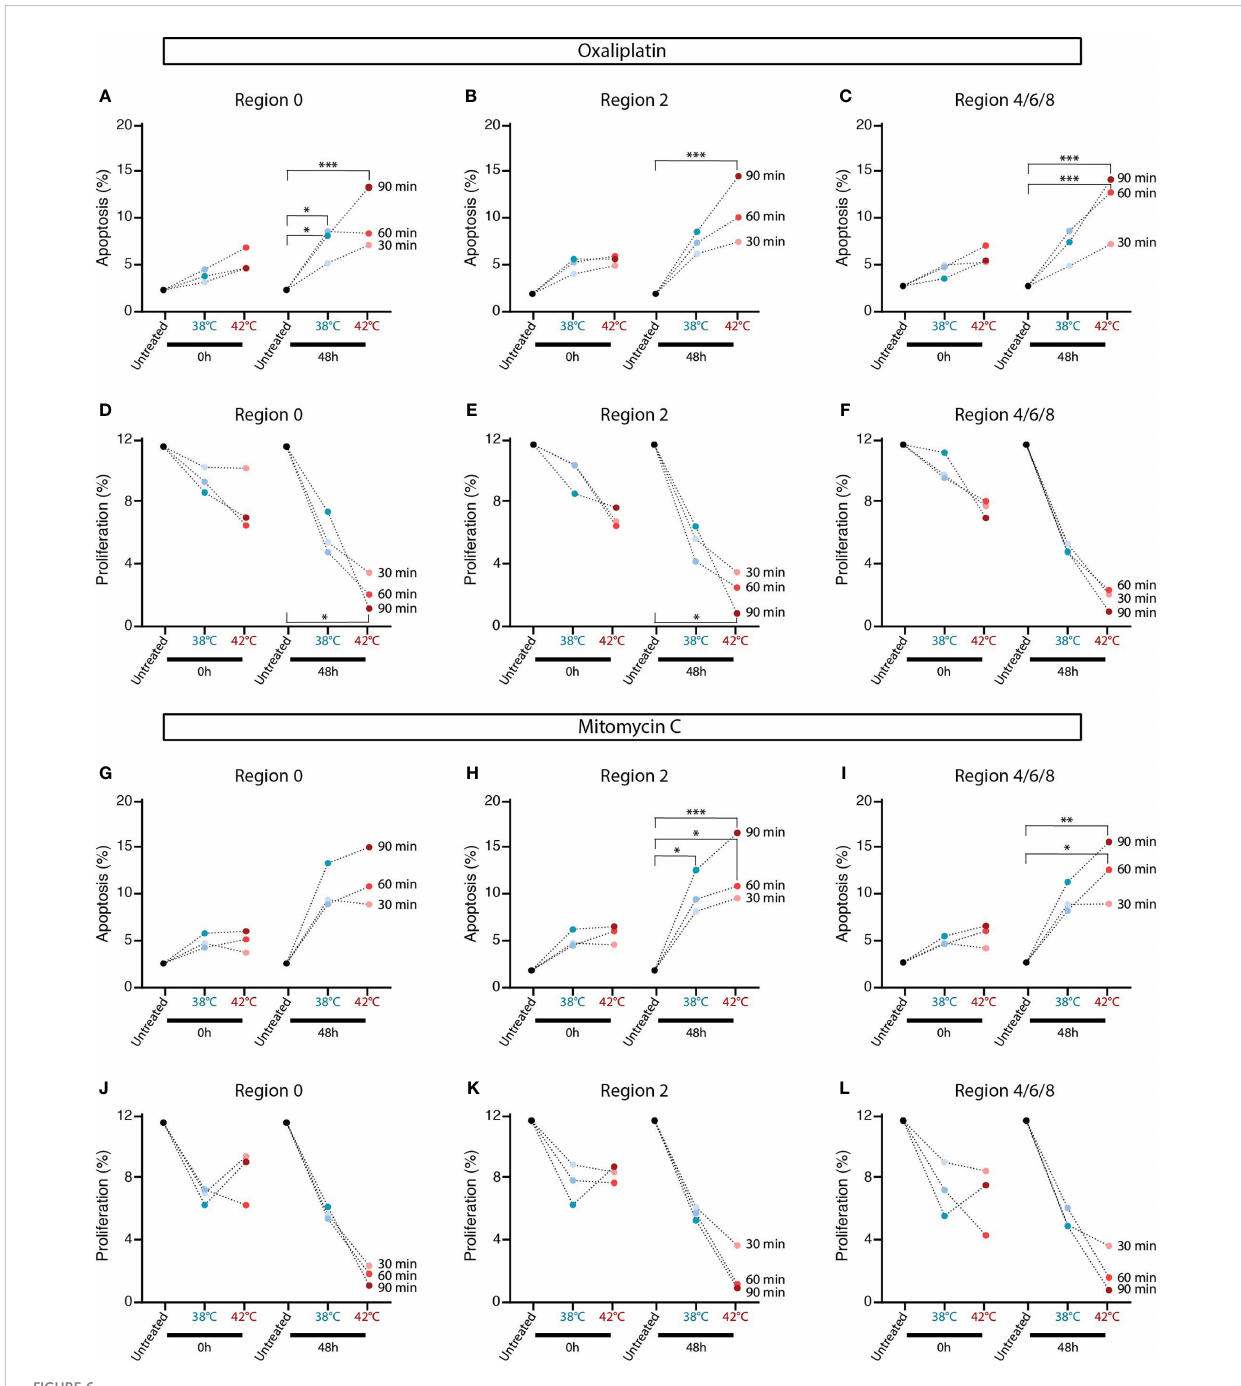
FIGURE 6 In oxaliplatin and mitomycin-C (MMC) HIPEC treated rats increased tumor cell apoptosis and reduced proliferation was observed. Percentages apoptosis in tumor lesions collected 0 hours or 48 hours after oxaliplatin- (A-C) and MMC-based (G-I) HIPEC treatment were analyzed using immunohistochemistry staining for cleaved caspase-3. Percentages proliferation in tumor lesions collected 0 hours or 48 hours after oxaliplatin- (D-F) and MMC-based (J-L) HIPEC treatment were analyzed using immunohistochemistry staining for Ki-67. Means of 4-5 animals are presented. The dotted line connect means with the same treatment duration. Signi fi cant p-values are reported as * <0.05, **<0.01 and